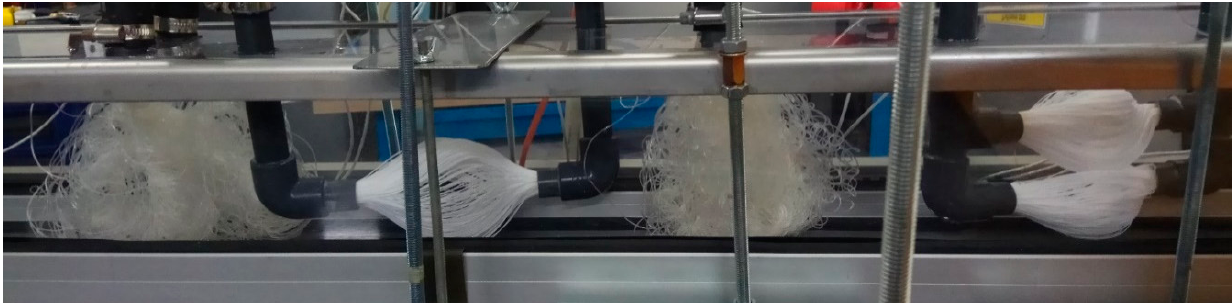
Figure 6. Testing section with MM007, condenser, MM004 and condenser (from right to left).